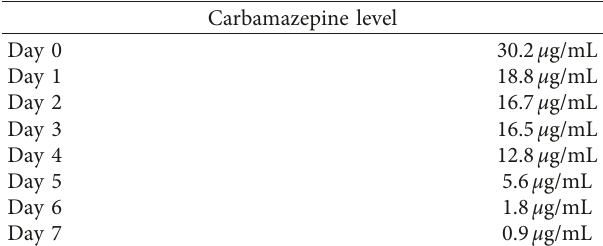
Table 1: Serial carbamazepine levels during